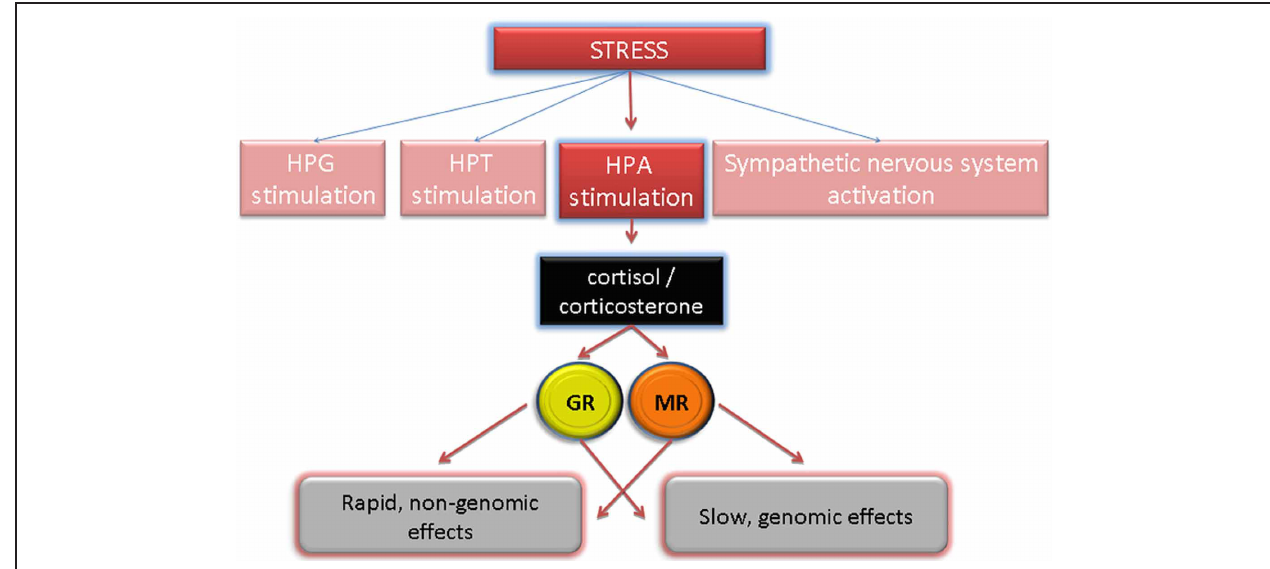
FIGURE 3 | HPA-induced stress hormone release and their signaling via respective receptors induce genomic (slow) and non-genomic (rapid) changes. GR, glucocorticoid receptor; MR, mineralcorticoid